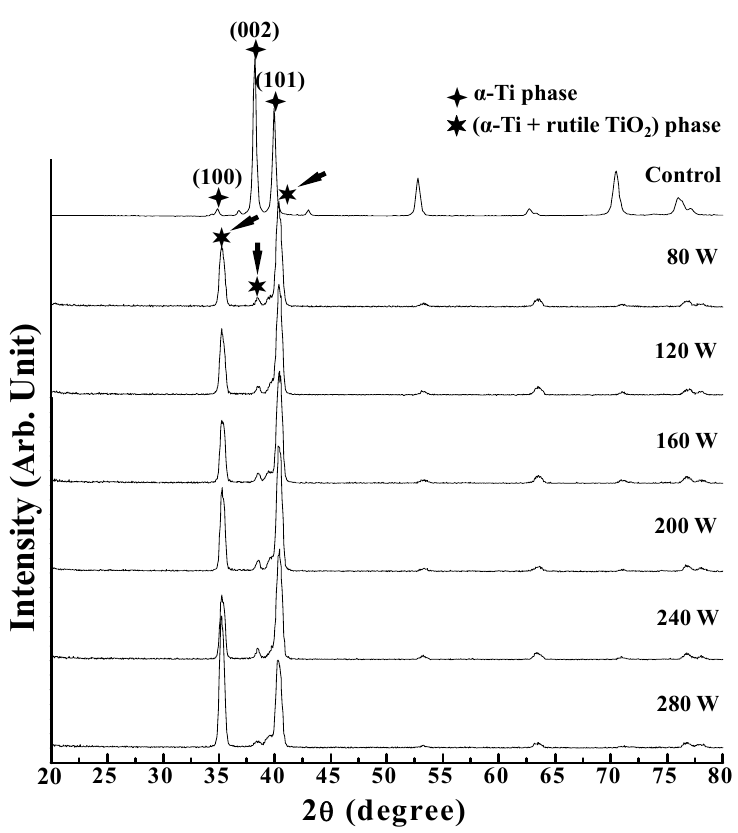
Figure 3. Grazing incidence X ‐ ray diffractometer (GIXRD) pattern taken from the control sample and the samples that had been plasma ‐ oxidized at different powers for 10 min. The peaks that indicated by arrows correspond to the ( α‐ Ti + rutile TiO 2 ) phase.